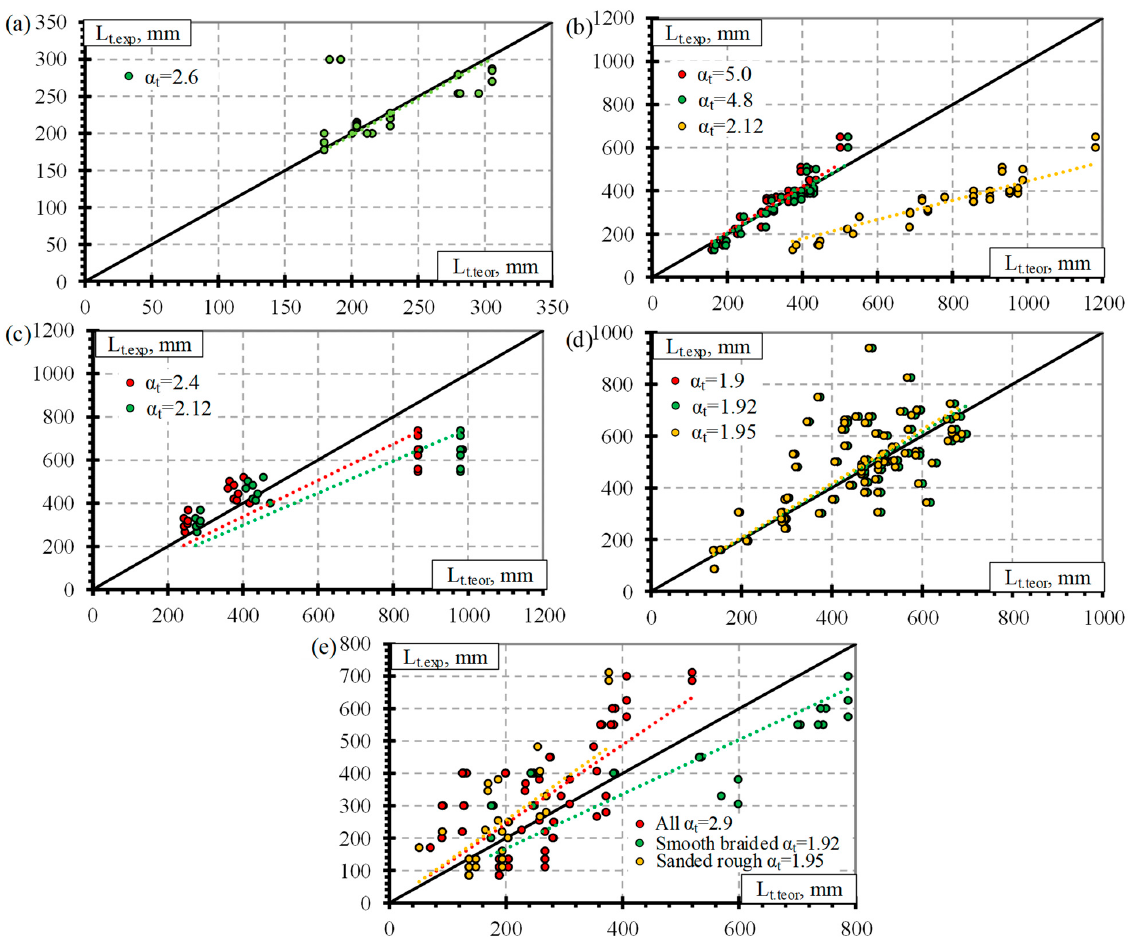
Figure 11. Comparison of experimental and theoretical transfer length results: ( a ) GFRP reinforce- ment, ( b ) CFCC strands with gradual transfer, ( c ) CFCC strands with sudden transfer, ( d ) CFRP bars, ( e ) AFRP bars. Table 12. Summary of the statistical results for L t.teor /L t.exp.